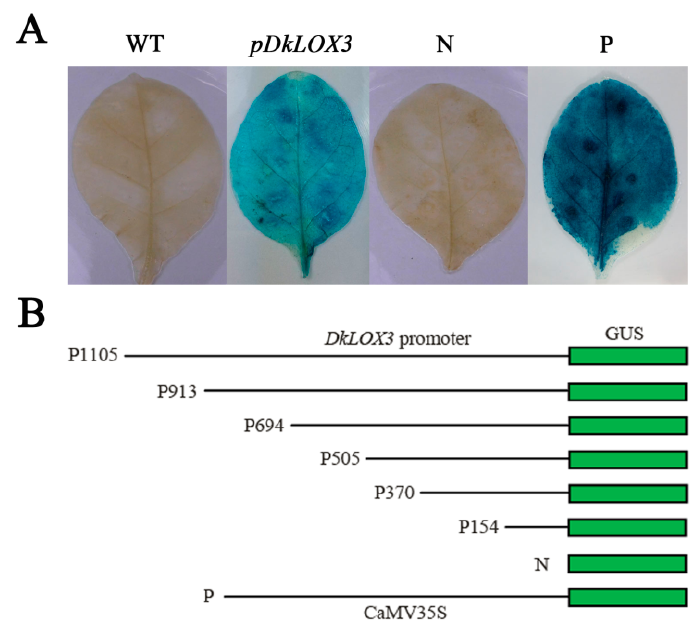
Figure 7. Histochemical staining ( A ) of transiently transformed tobacco leaves and schematic diagram of vector constructs ( B ) for the DkLOX3 promoter. WT wild type; N negative control; P positive control.